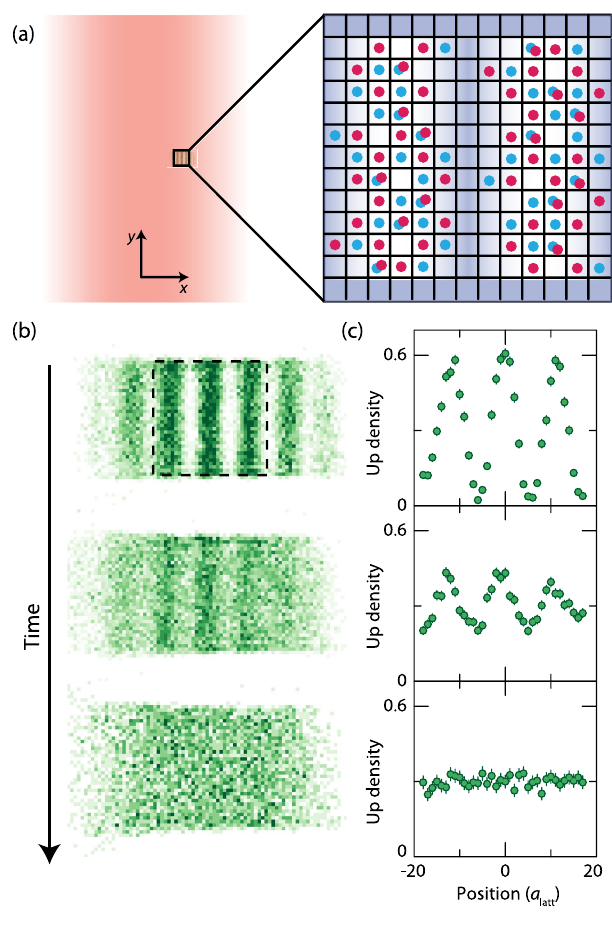
FIG. 1. Experimental setup and measurements. (a) An off- centered beam generates a potential at the atoms that is approx- imately linear in x and independent of y . Blue-detuned light projected through a spatial light modulator is used to prepare the initial density waves of our experiments, with tunable wavelength in the direction of the tilt and hard walls a distance of 35 a apart latt in the perpendicular direction. The figure is a schematic intended to portray the experimental setup and is not to scale. (b) Spin-up ( ↑ ) component of density vs time, averaged over about 10 images. The dotted square denotes the region of interest (ROI) in which our measurements were taken. (c) Evolution of the y -averaged density in the ROI of panel (b) as a function of x . The data correspond to a system with interaction energy U=t h ¼ 3 . 9 ð 1 Þ , tilt strength Fa =t 0 . 99 ð 3 Þ , and an initial density h ¼ latt 11 . 46 ð 3 Þ . The density profile modulation of wavelength λ =a latt ¼ is shown at times 0 ms (0 ℏ =t h ), 0.5 ms (2.6 ℏ =t h ), and 15 ms (77 ℏ =t h ) from top to